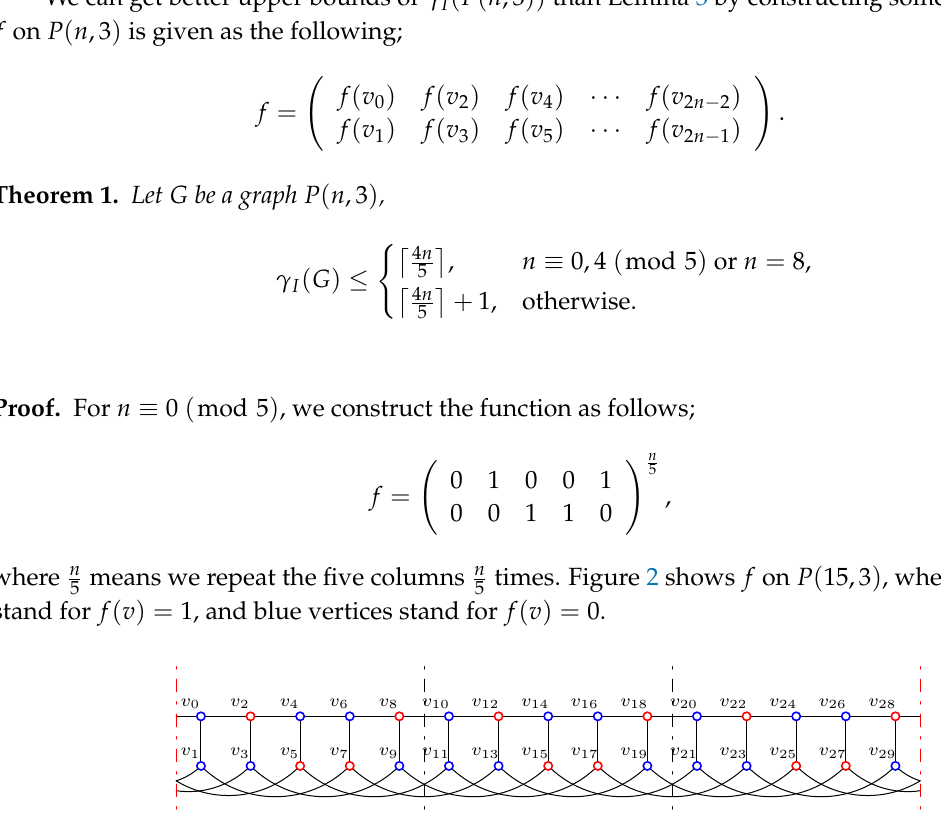
Figure 2. The function f on P ( 15,3 ) .